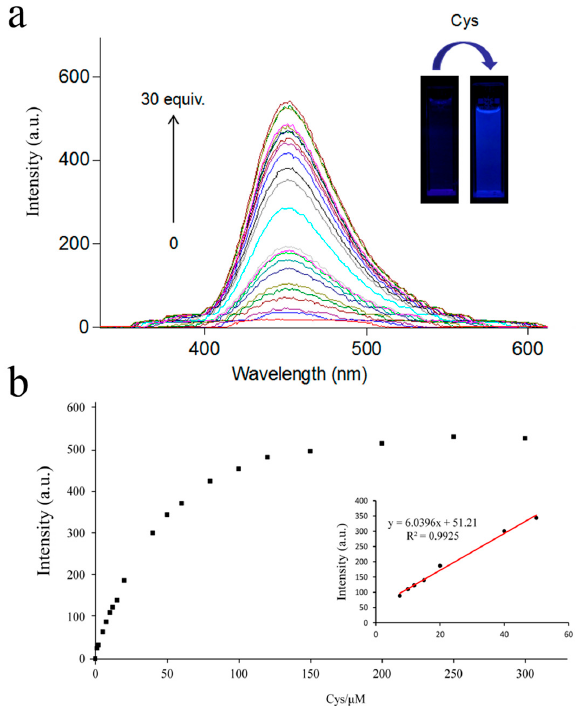
Figure 6. ( a ) Fluorescent spectral changes ( b ) The fluorescence intensity at 450 nm of probe (10 μ M) upon addition of Cys (0–300 μ M) in buffer solution (DMSO:PBS = 4:6, PH 7.4), incubated 30 min before detected. λ ex = 325 nm, λ em = 450 nm.